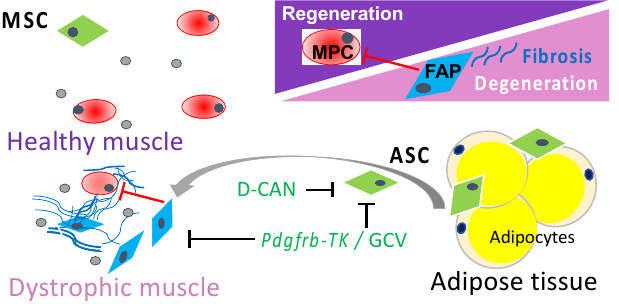
Figure 1. A schematic representation of the working hypothesis. In DMD muscle, resident MSCs and adipose stromal cells (ASCs) serve as a source of fibroadipogenic progenitors (FAPs) that promote fibrosis, suppress the activity of muscle progenitor cells (MPCs), and promote DMD pathogenesis. Ablation of proliferating MSCs (by TK/GCV suicide gene therapy) or ASCs (with D-CAN) is expected to suppress DMD progression.